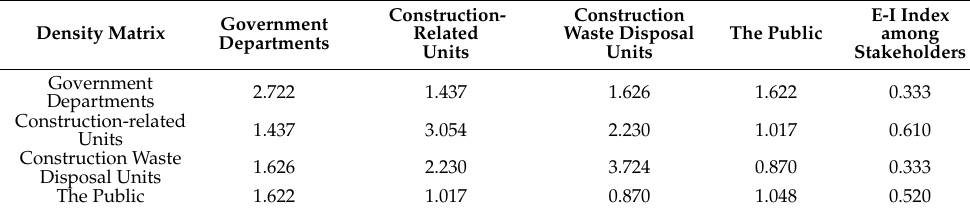
Table 5. Density matrices and E-I indices among